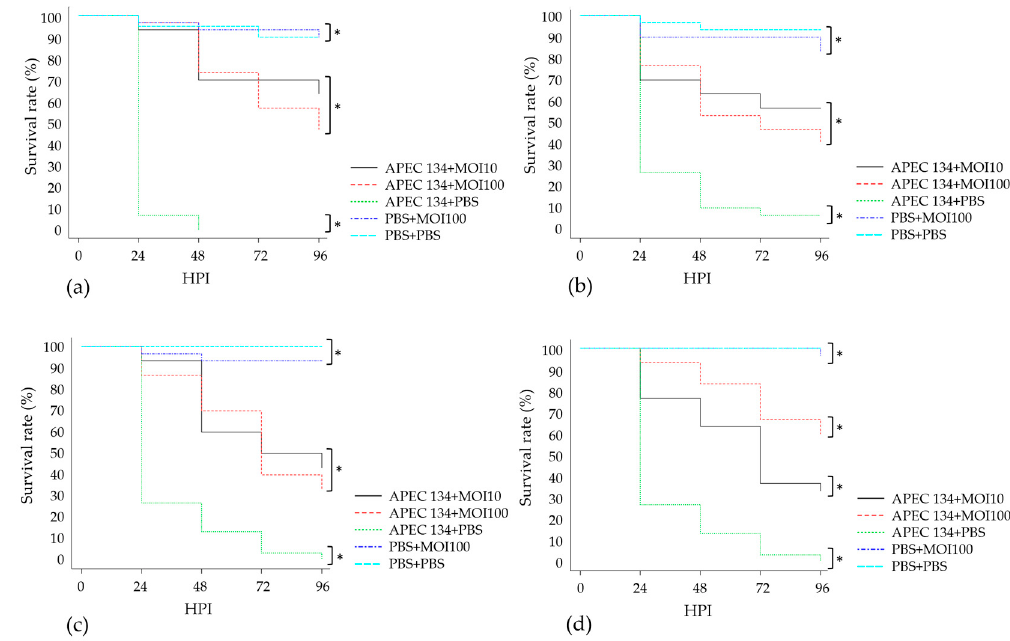
Figure 9. Kaplan–Meier survival curves of the experiments with G. mellonella larvae inoculated with E. coli O18:K1 (APEC 134) or PBS and treated with phages ( a ) vB_EcoS_K1-ULINTec2, ( b ) vB_EcoP_K1-ULINTec4, ( c ) vB_EcoP_K1-ULINTec6, ( d ) vB_EcoP_K1-ULINTec7, or PBS two hours later. Each group contained 30 larvae separated in 3 groups of 10 larvae. MOI: multiplicity of infection. HPI: hours post inoculation. p -value (*) < 0.05.